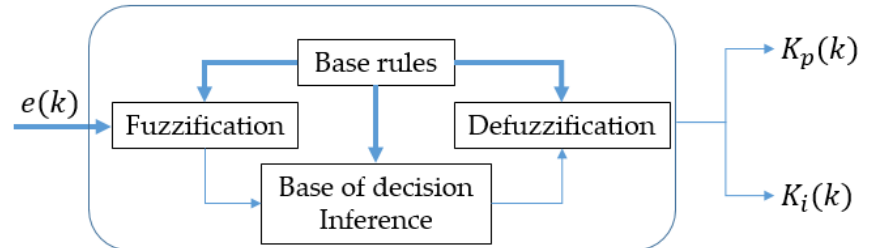
Figure 8. Fuzzy structure for PI gain scheduling.